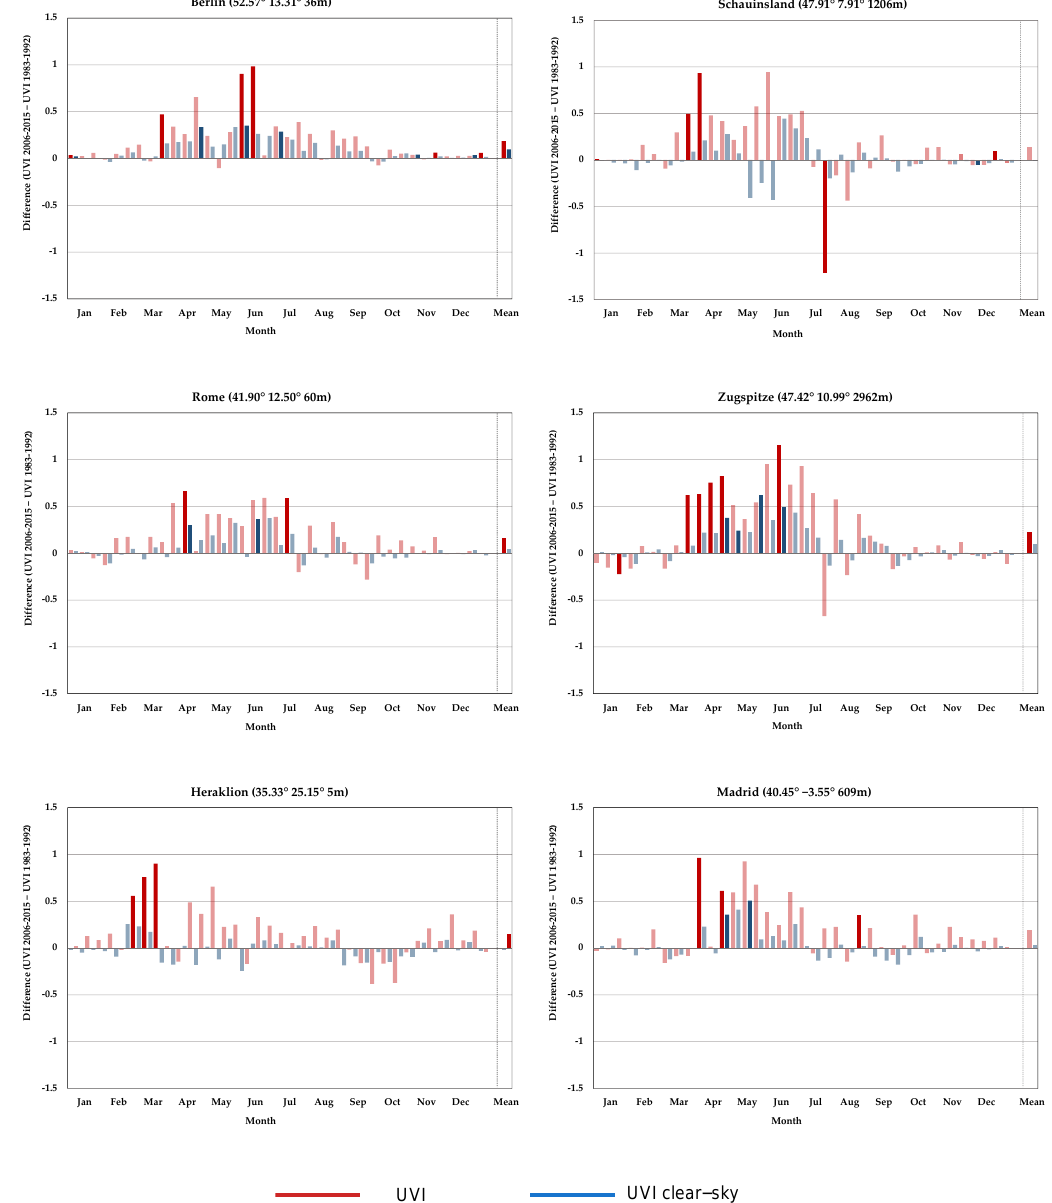
Figure 9. Satellite-based difference of noontime UVI and noontime UVI clear − sky between the time periods 2006–2015 and 1983–1992 based on 10-day means and the annual mean for each location. Statistically significant differences are shown in intense red colour for UVI and intense blue colour for UVI clear − sky (5% significance